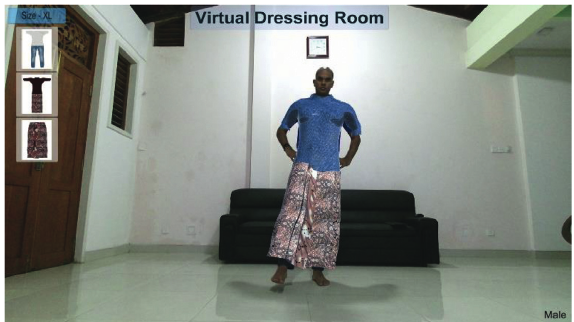
Figure 11: Virtual dressing room for 3D clothes simulation. Table 2: Manual measurements and noncontact body parameter measurements (units in